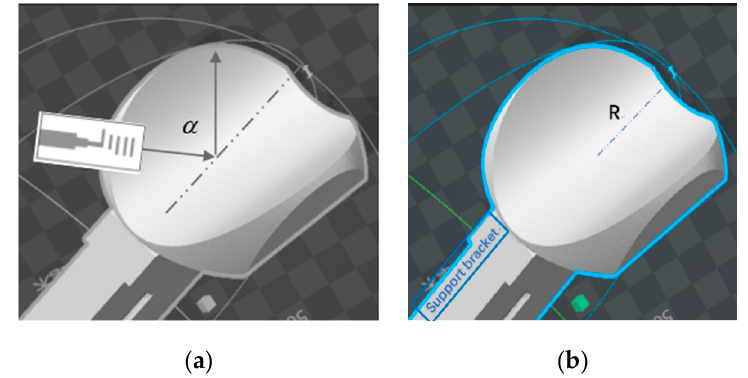
Figure 4. Cylindrical parabolic antenna ( a ) Angle α ( b ) Profile radius R. Figure 4 . Cylindrical parabolic antenna ( a ) Angle 𝛼 ( b ) Profile radius R.